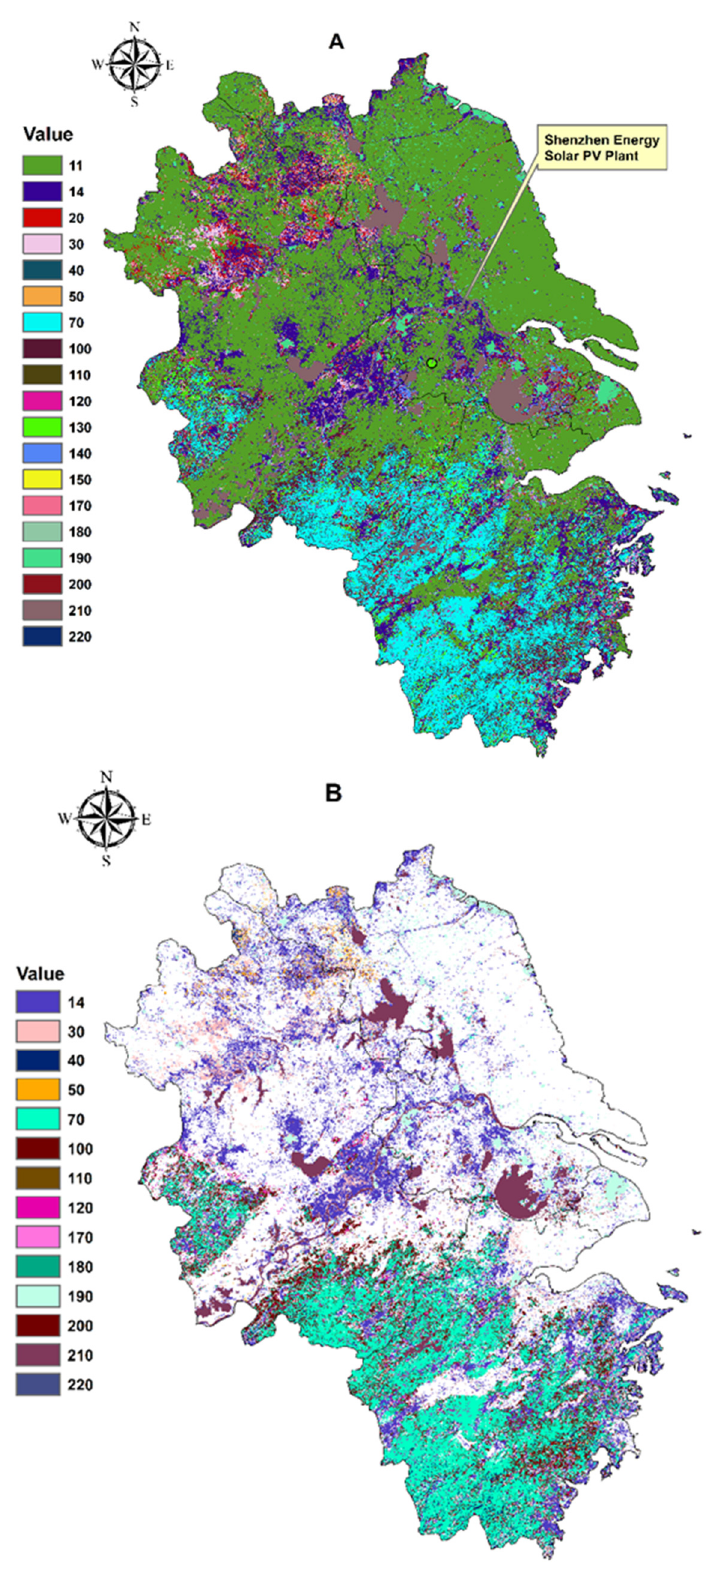
Figure 2. Yangtze River Delta region (YRDR): ( A ) land use land cover; ( B ) excluded land use land cover.